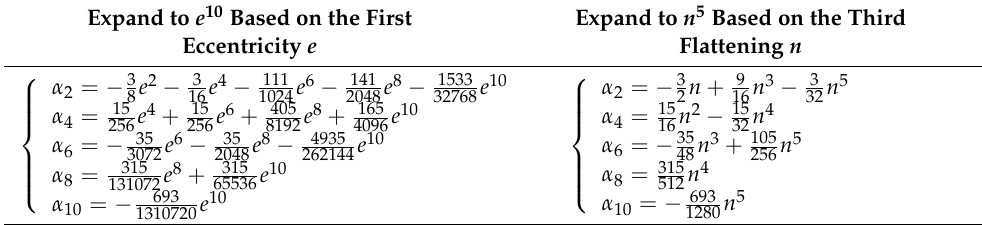
Table 1. Coefficients in Equation